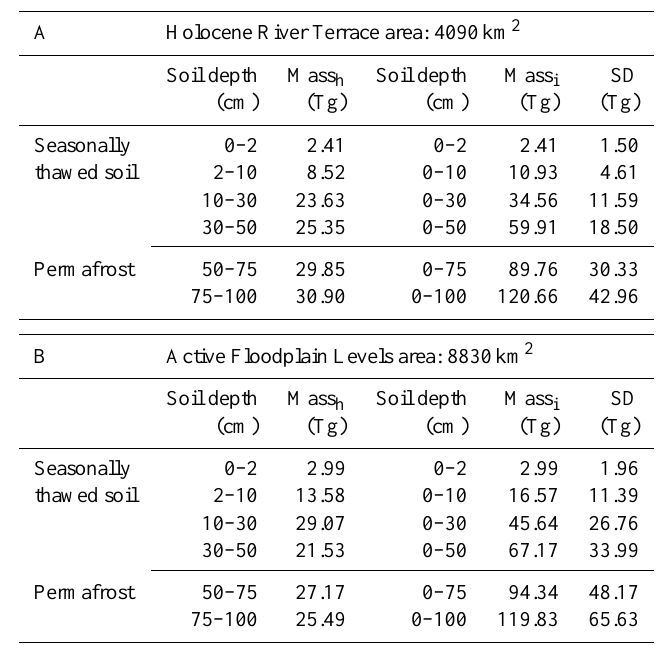
Table 8. The vertical distributions of the total soil organic carbon mass within the seasonally thawed and perennially frozen soil for the Holocene river terrace (A) and the active floodplain levels (B) in the Lena River Delta. Represented are the estimated mean soil carbon mass (Tg) for all investigated soil horizons (Mass h ) and the estimated mean soil organic carbon mass (Tg) for different depth increments (Mass i ) with the respective standard deviations.